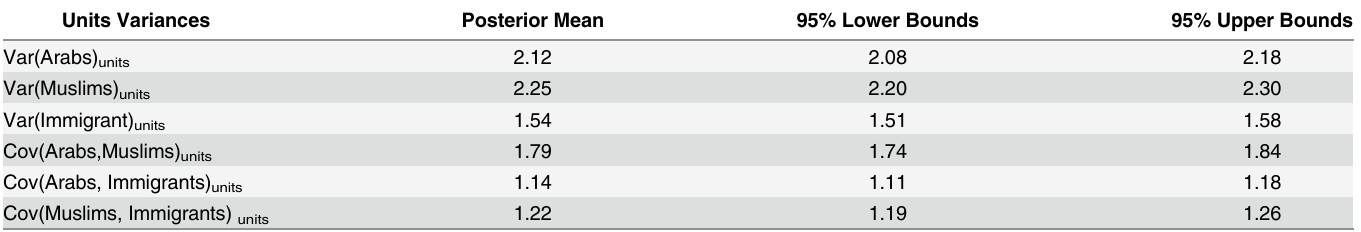
Table 4. Residual Variance Structure (R-Structure units).